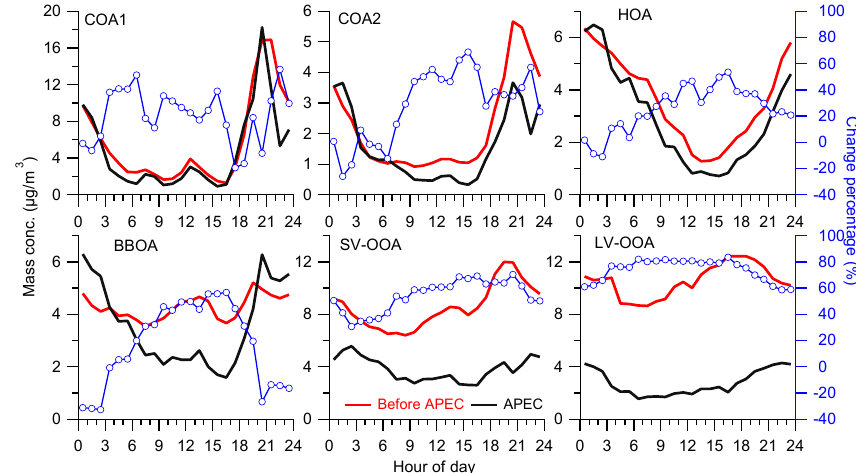
Figure 5. Diurnal profiles of the mass concentrations of organic aerosol (OA) factors measured before and during the Asia-Pacific Economic Cooperation (APEC) summit. Also shown are the changes in percentage of OA factors measured during